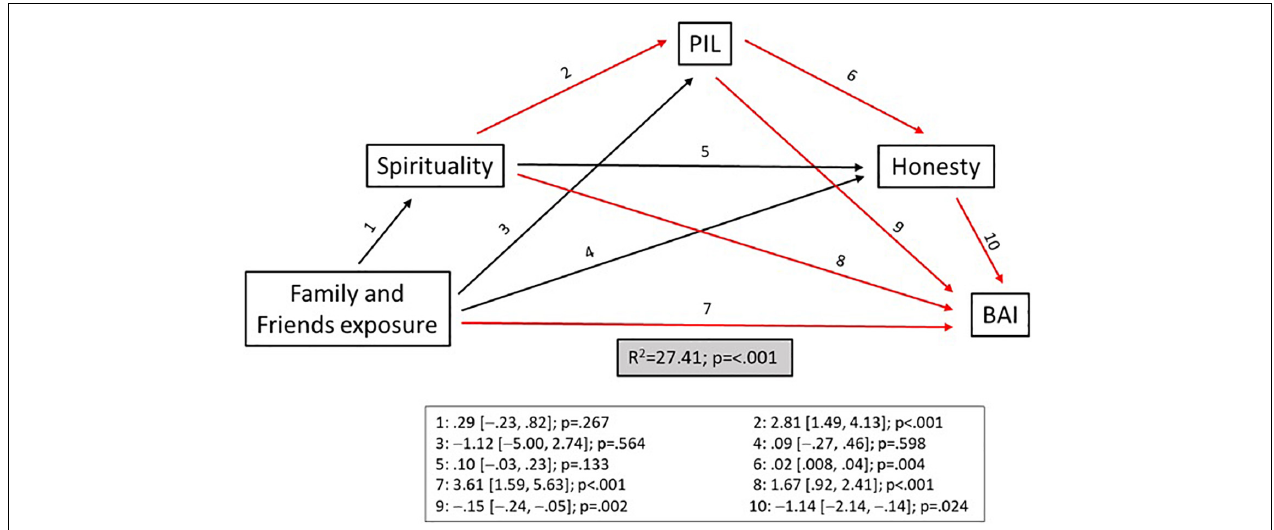
FIGURE 1 | Explanatory model between purpose in life, spirituality, honesty, exposure, of family and friends, and the Beck’s Anxiety Inventory. Significant relationships are marked in red. BAI, Beck Anxiety Inventory ; PIL, purpose in life.